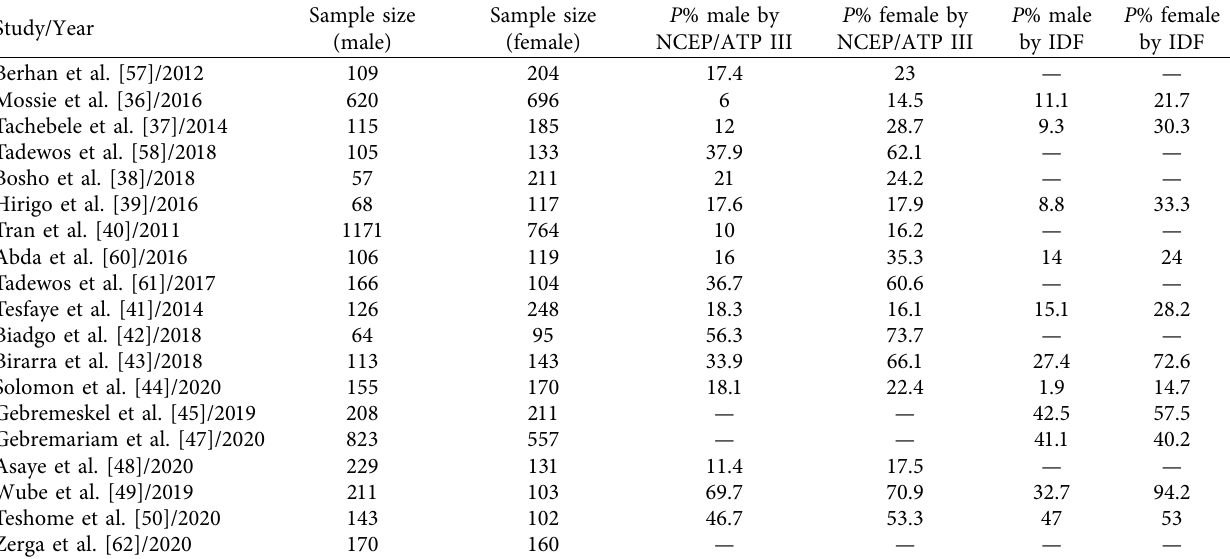
Figure 3: Forest plot of metabolic syndrome prevalence in Ethiopia based on IDF criteria. Table 4: Pooled estimates of metabolic syndrome based on